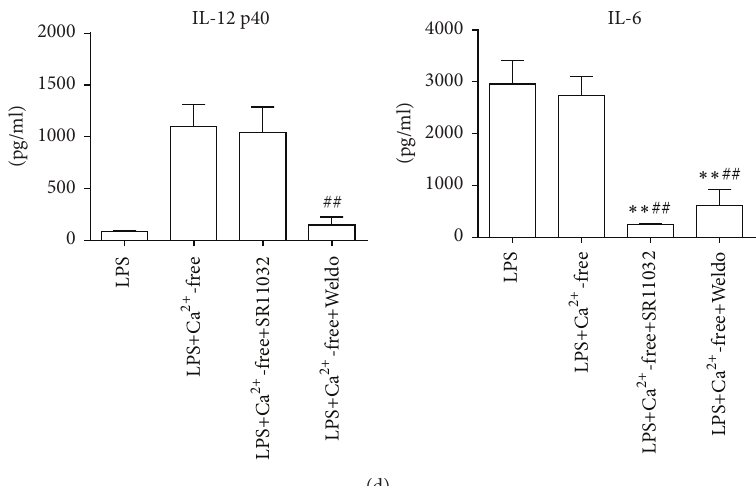
Figure 7: SIRT1 selectively attenuates transcription activity of NF- 𝜅 B and suppresses IL-12 expression in LPS-stimulated RAW 264.7 cells. (a) Cells were treated with 1 𝜇 M STO-609 alone or combined with 2 𝜇 M SRT1720 or 1mM AICAR for 30 min before 100 ng/mL LPS stimulation (left). Cells were treated with 5 𝜇 M Compound C alone or with 2 𝜇 M SRT1720. Cells were also treated with 1mM AICAR alone or with 2 𝜇 M EX527 (right). Supernatants were collected at 24 h and IL-12 p40/IL-12 p70 (c) and IL-6 (d) levels were detected by ELISA ( 𝑛 = 3 ). (b) Cells were transfected with plasmid pGL-luc2P/NF- 𝜅 BRE for 24 h and furthertreated with 100ng/mL LPS in normal DMEM,calcium-free DMEM, DMEM with 2 mM CaCl 2 , DMEM with 1mM AICAR, or DMEM with 2 𝜇 M SRT1720 for 6h. Relative luciferase activity of NF- 𝜅 B against medium was presented. ∗∗ 𝑃 < 0.01 versus medium; ## 𝑃 < 0.01 versus LPS ( 𝑛 = 3 ). Cells were also transfected with plasmids pAP1-luc and pIRF3-luc for 24 h and further treated with 100ng/mL LPS and LPS plus calcium-free DMEM for 6h. Relative luciferase activity of AP-1 and IRF3 was detected ( 𝑛 = 3 ). (c) Cells were treated with LPS alone with 5 𝜇 M SR11302 or 10 𝜇 M wedelolactone (Weldo) for 24 h. Supernatant IL-12 p40/p70 and IL-6 levels were detected by ELISA. ## 𝑃 < 0.01 versus LPS ( 𝑛 = 3 ). (d) Cells were treated with LPS, LPS with calcium-free medium, or LPS with calcium-free medium alone with 5 𝜇 M SR11302 or 10 𝜇 M wedelolactone (Weldo) for 24 h. Supernatant IL-12 p40/p70 and IL-6 levels were detected by ELISA. ∗∗ 𝑃 < 0.01 versus LPS; ## 𝑃 < 0.01 versus LPS plus calcium-free medium ( 𝑛 = 3